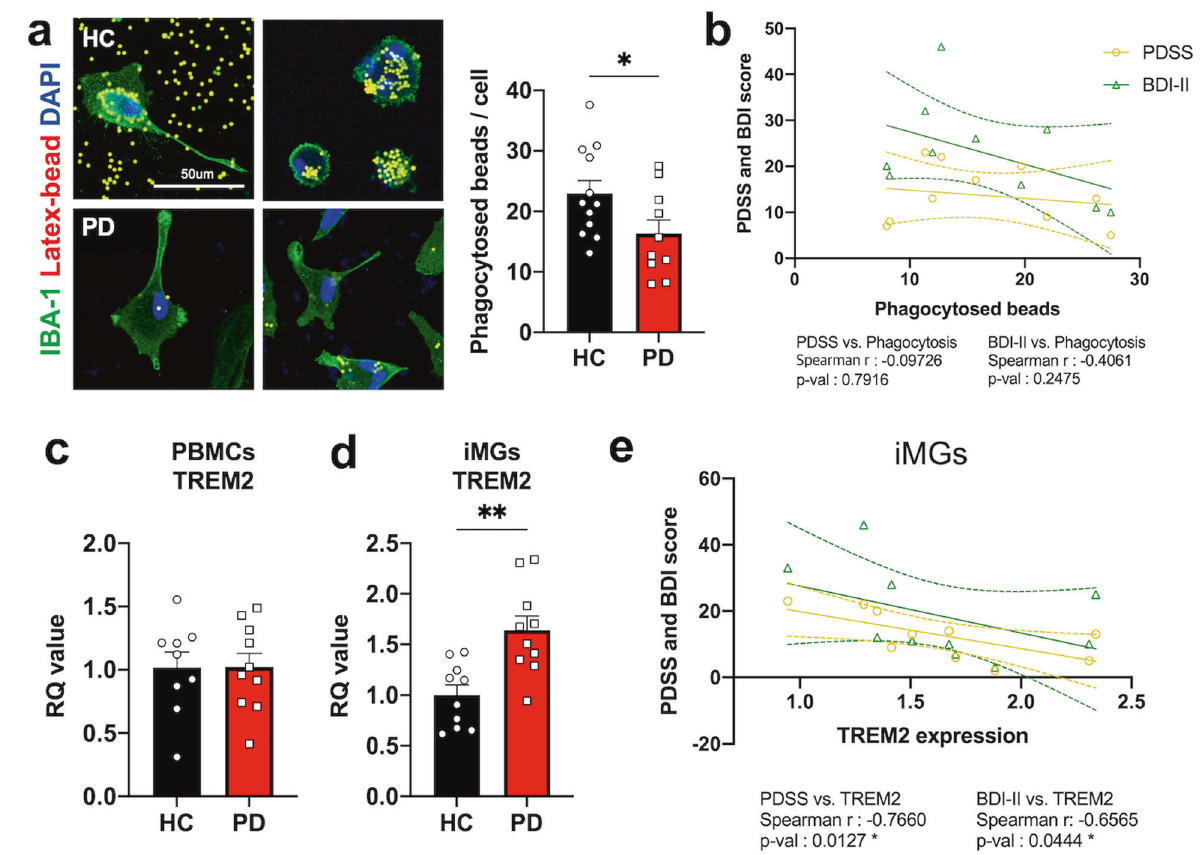
Fig. 2 The phagocytic function relevance of PD-iMGs to panic symptoms. a The representative images (×40) of HC- and PD-iMGs during phagocytosis. The bar graph (Right side of images) indicates phagocytosed beads in HC and PD respectively (For quanti fi cation, 2 fi elds per subject were used; total subjects HC = 12, PD = 10). b Correlation analysis between phagocytosed beads and clinical indicators of panic symptoms. c , d qRT-PCR analysis for TREM2 expression in PBMCs and iMGs of both HC and PD. e Correlation analysis between TREM2 mRNA expression and clinical indicator of panic symptoms. The data shown are as mean ± standard error of the mean (SEM). To compare statistical signi fi cance between the two groups, we conducted an unpaired t test and spearman correlation analysis. * P < 0.05, and ** P < 0.01 compared with the